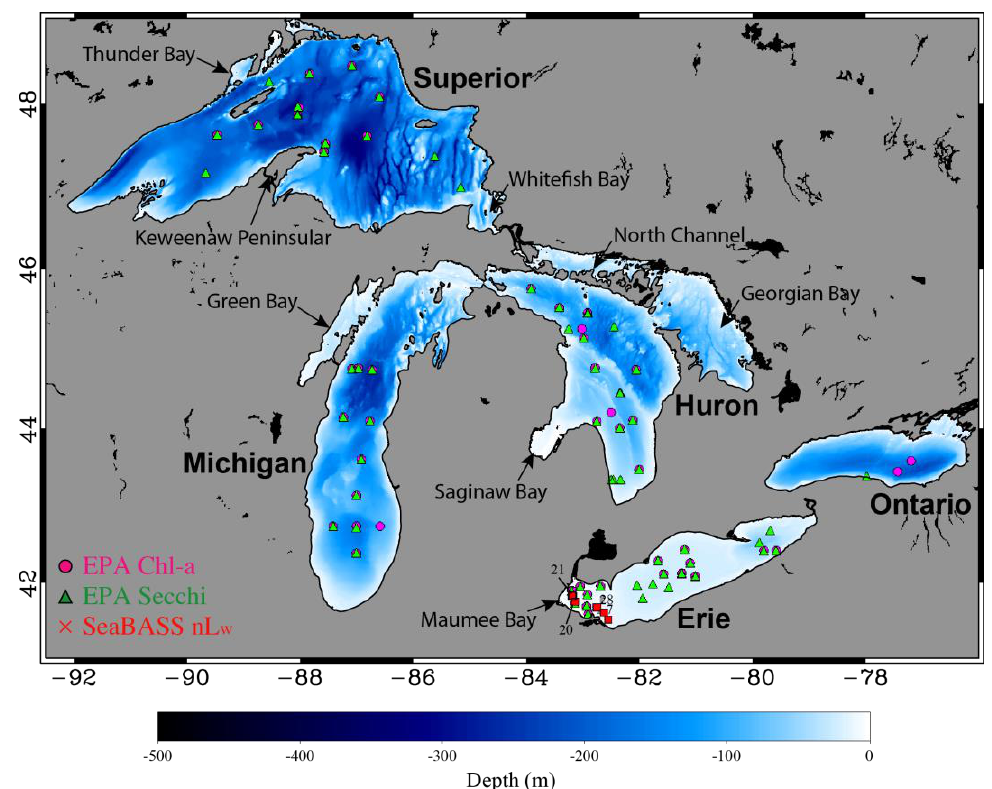
Figure 1. Geography of the Great Lakes with indications of in-situ data locations for SD (purple circles) and Chl-a (green triangles) measurements from the EPA GLENDA, and radiance measurements (red squares) from the NASA SeaBASS. The in-situ station numbers are noted in Lake Erie.